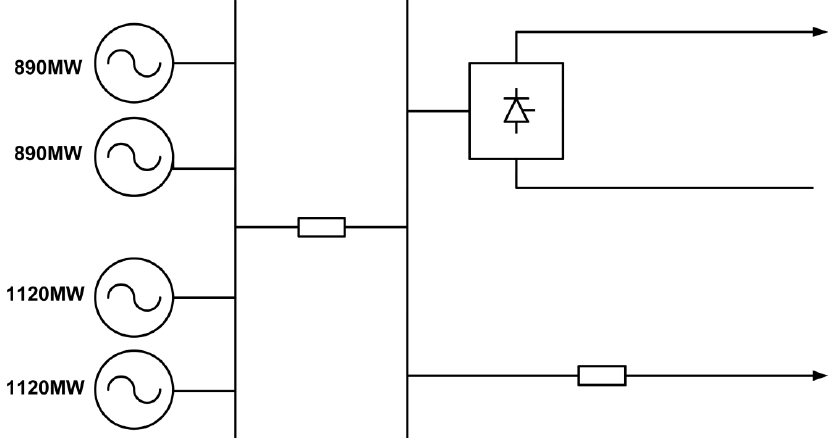
Figure 5. Electrical network representation of the case